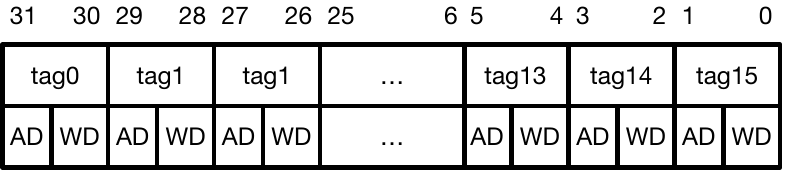
Figure 3. TPCR (Tag Permission Configuration